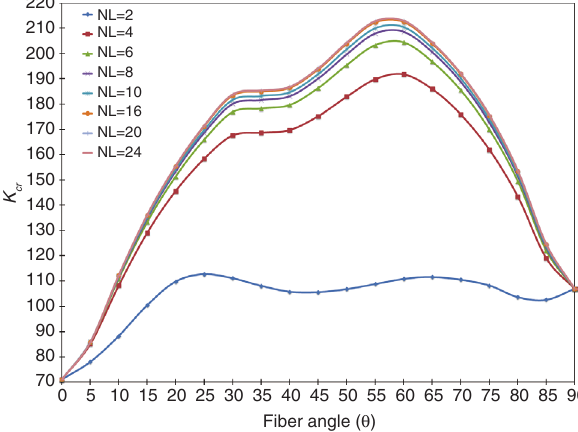
Figure 10 Critical buckling load parameter for simply supported antisymmetric cylindrical skew panel (Ø = 30 ° , α = 45 ° ).